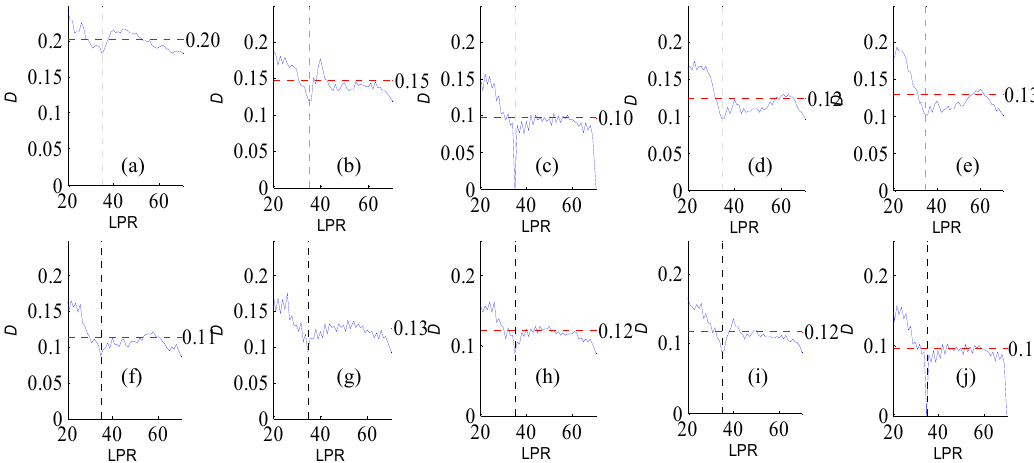
Figure A22. Variation of flow regime alteration degree (D) measured by the RVA with change in the length of post-impact flow time series (LPR) under a periodicity of 35 years. ( a – j ) correspond to pre-impact flow time series length = 25, 30, 35, 40, 45, 50, 55, 60, 65, and 70 years, respectively. The abscissa value for the vertical dotted line is 35. The ordinate value for the horizontal dotted line is the mean degree of flow regime alteration in each subfigure.